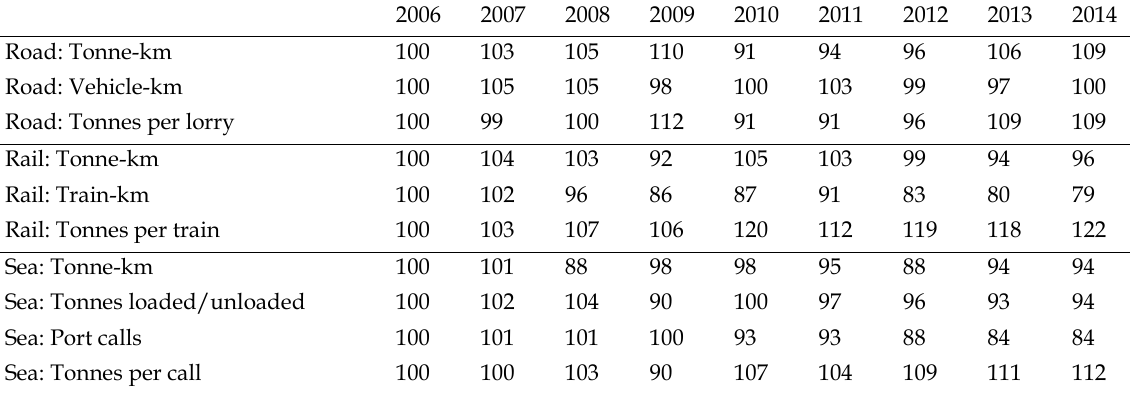
Table 1. Table 1. Index of tonne-km, vehicle-km and tonnes per vehicle for road and